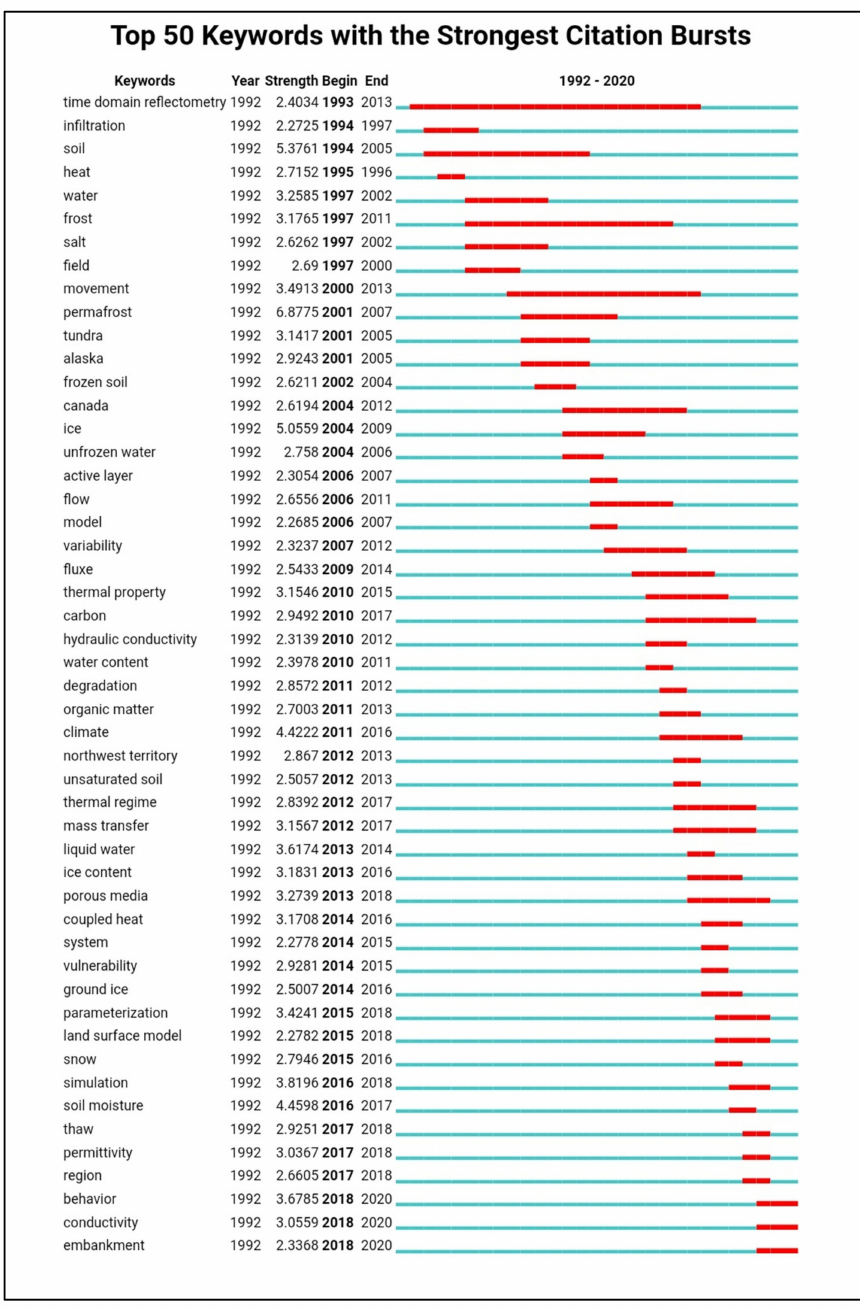
Figure 7. The strongest citation bursts map showed the top 50 keywords in frozen soil from 1992 to 2020 by CiteSpace. Blue indicates the time when keywords appear, and red indicates the time when keywords